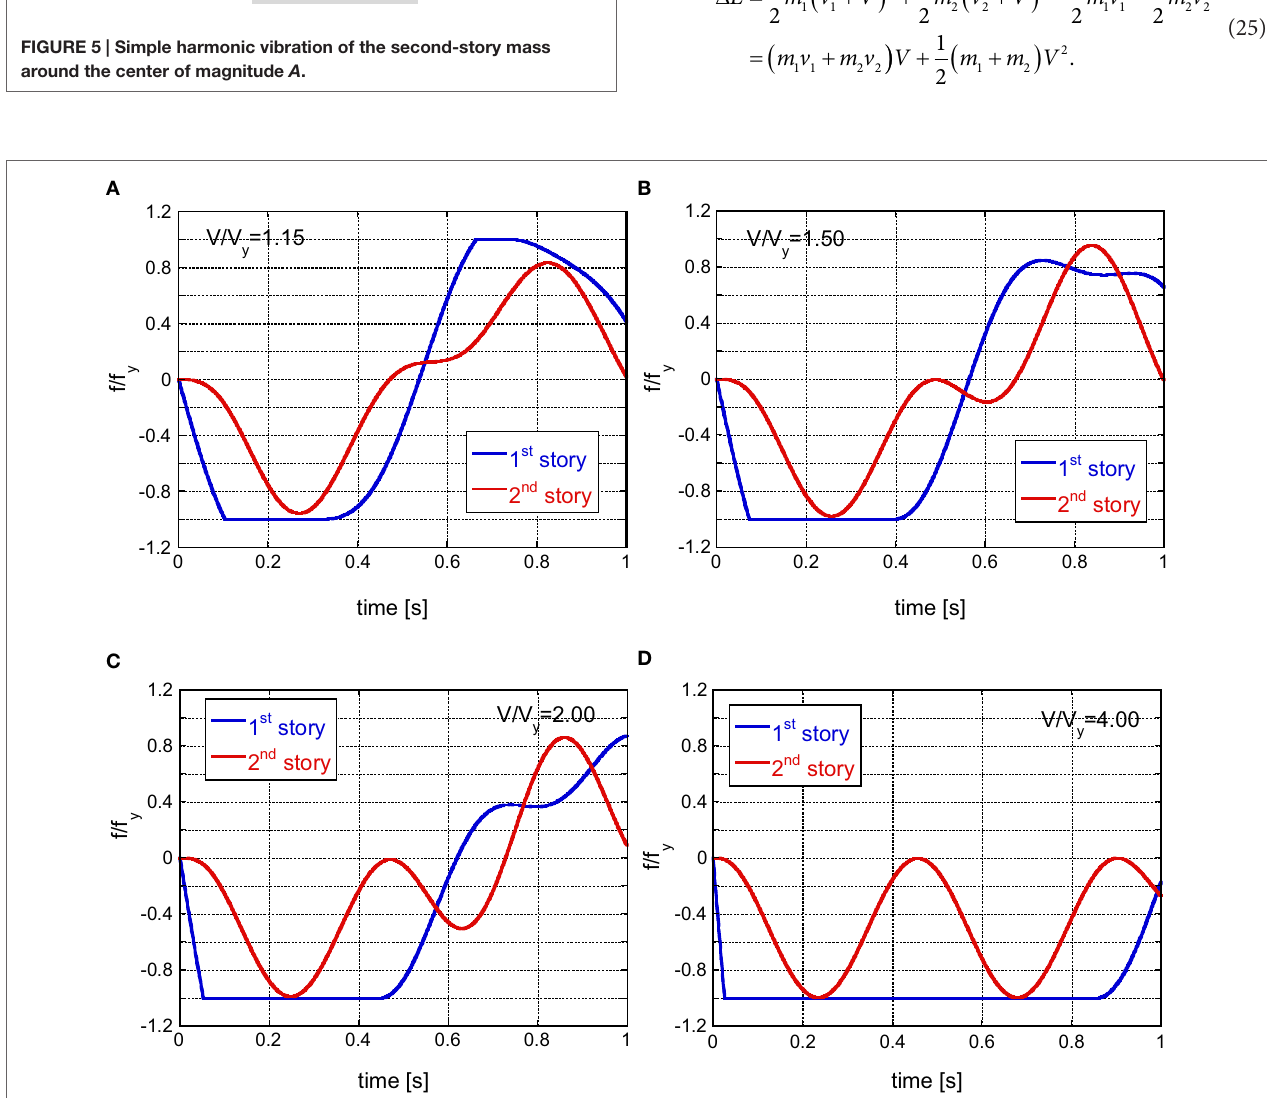
FigUre 6 | examples of the time histories of the restoring forces in the first and second stories for a model of equal mass, equal story stiffness, and equal yield interstory drift subjected to the single impulse at t = 0 with V / V y = 1.15, 1.5, 2, 4 . (a) V / V y = 1.15 (B) V / V y = 1.5. (c) V / V y = 2.0. (D) V / V y =